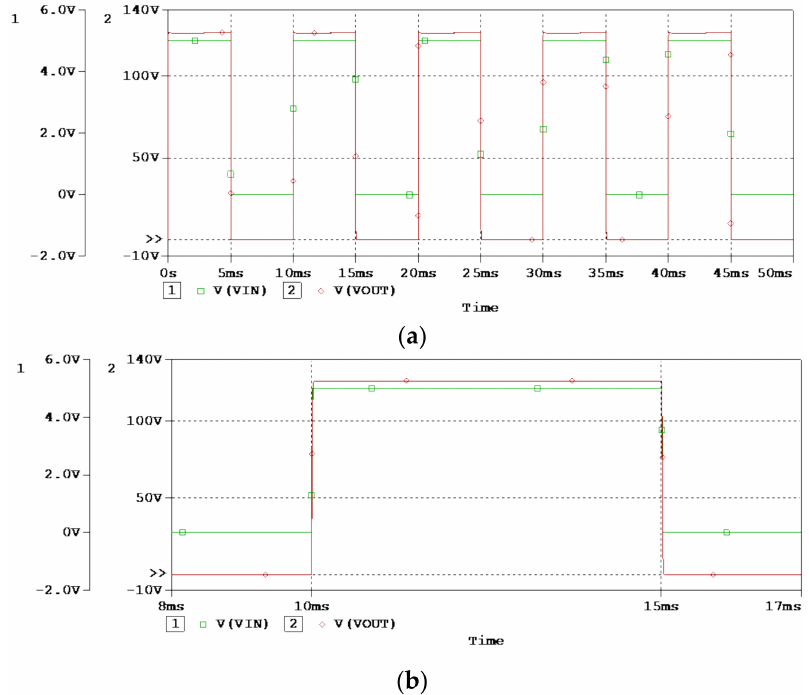
Figure 13. Simulated square wave input–output response for the power amplifier using high-voltage operational amplifiers; ( a ) the overall perspective waveform; ( b ) the rising edge and the falling edge of the waveforms.